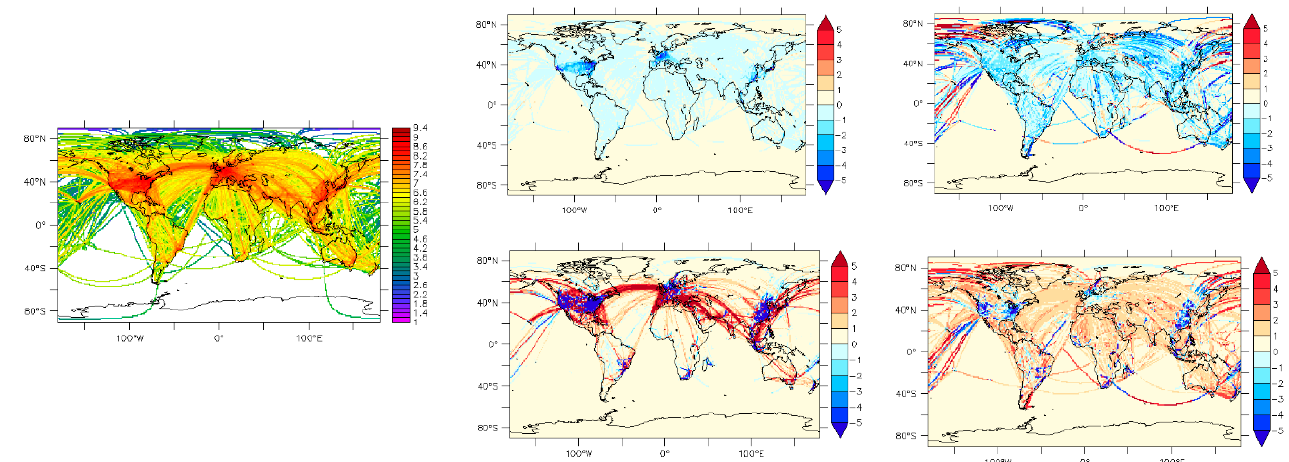
Figure A1. Global distribution of aviation CO 2 emission [kg, logarithmic]: reference case ( left ), and difference between inventories Flying Higher ( upper ) and Flying Lower ( lower ) compared to reference case as absolute differences ( middle ) and relative difference [%] ( right ).